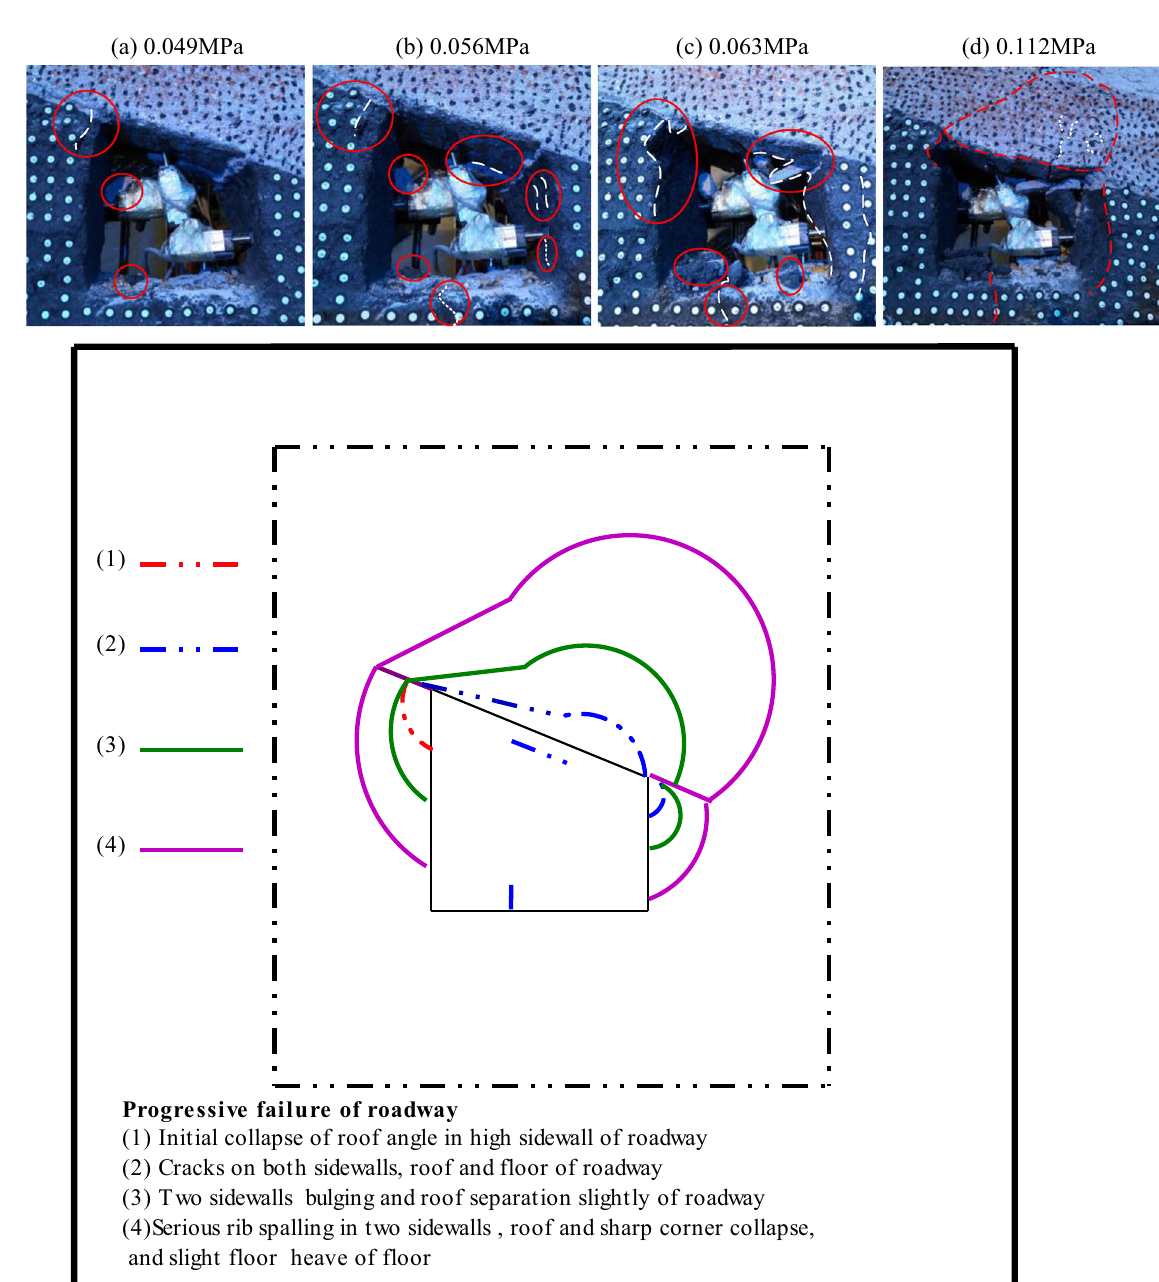
Figure 19. Cyclic failure of